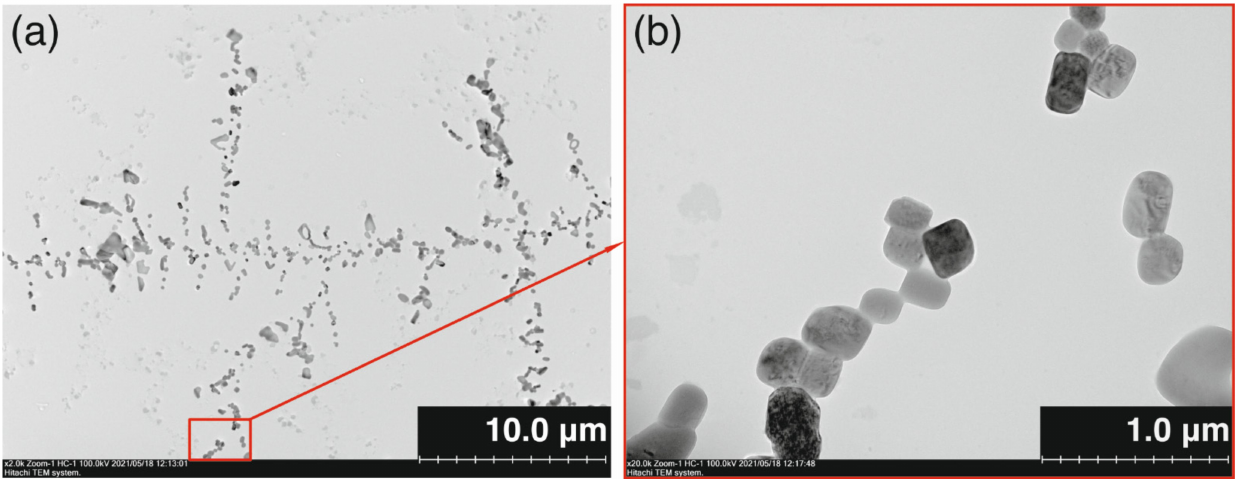
Figure 3. TEM images of associates G1-cone-HCl /DNA (5 × 10 − 5 M of G1-cone-HCl , 5.565 × 10 − 5 M DNA base pairs). Scale bar ( a ) 10 µ m; ( b ) 1 µ